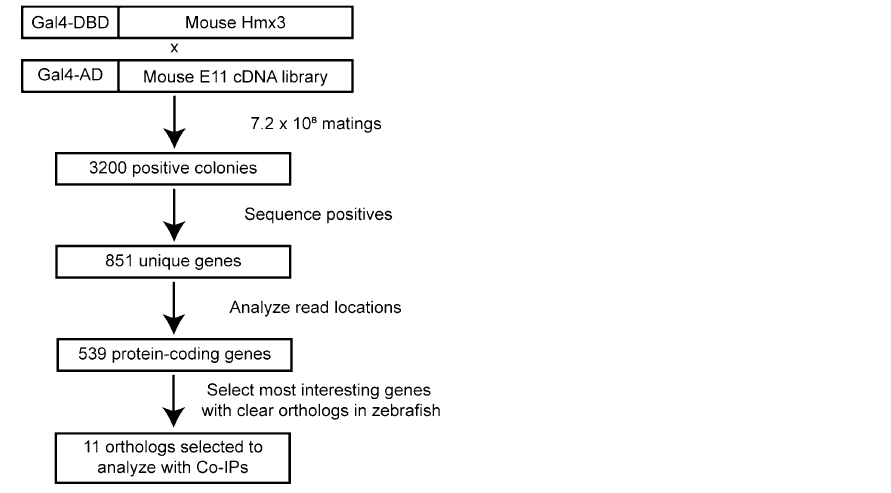
highest amino acid conservation compared to the mouse protein.